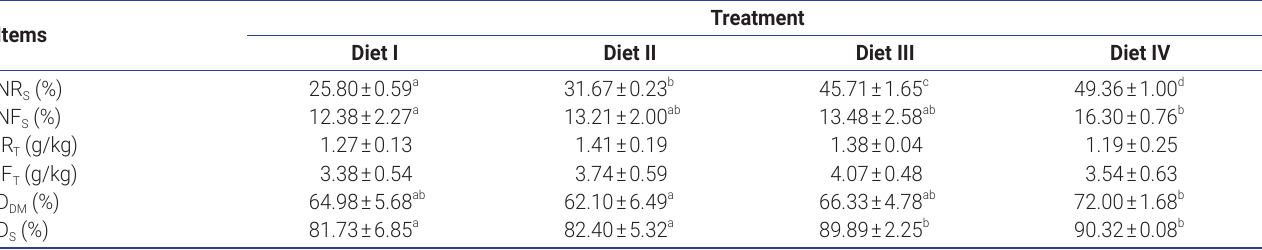
Table 3. Dietary starch digestibility in small intestine of weaned piglets in Exp 1 Items